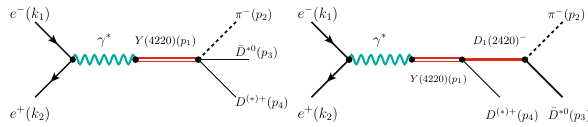
Fig. 1 The schematic diagrams of two main production contributions in the three-body open charm processes e + e − → D ( ∗ ) + ¯ D ∗ 0 π −